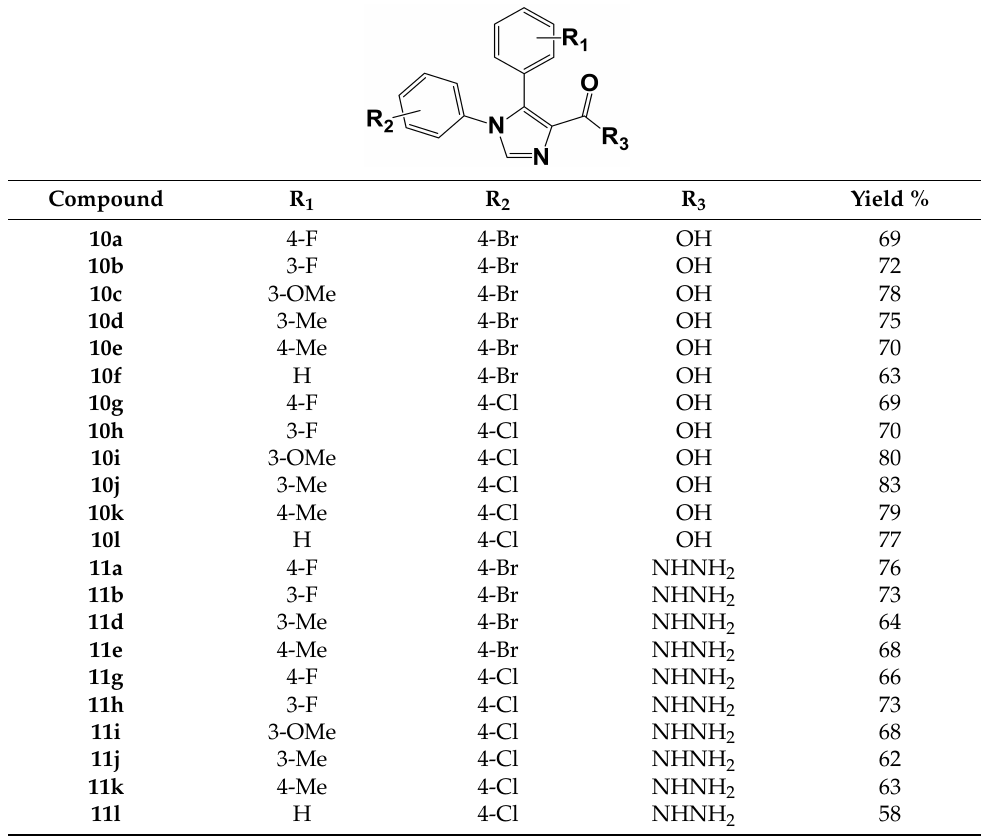
Table 2. Isolated yields of 1,5-diaryl-1 H -imidazole-4-carboxylic acids 10 and 1,5-diaryl-1 H -imidazole- 4-carbohydrazides 11